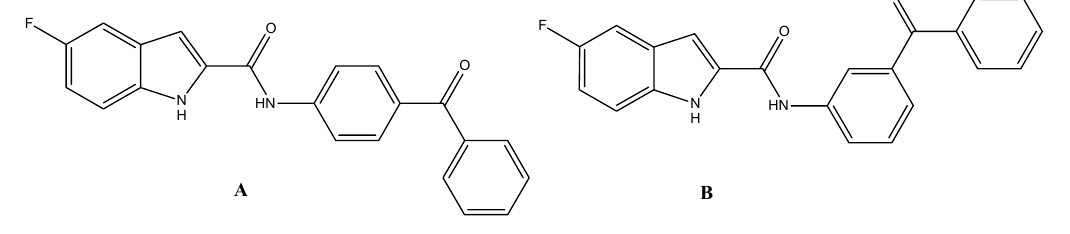
Figure 1. N-(Benzoylphenyl)-5-fluoro-1H-indole-2-carboxamide derivatives ( A , B ) with significant hypolipidemic